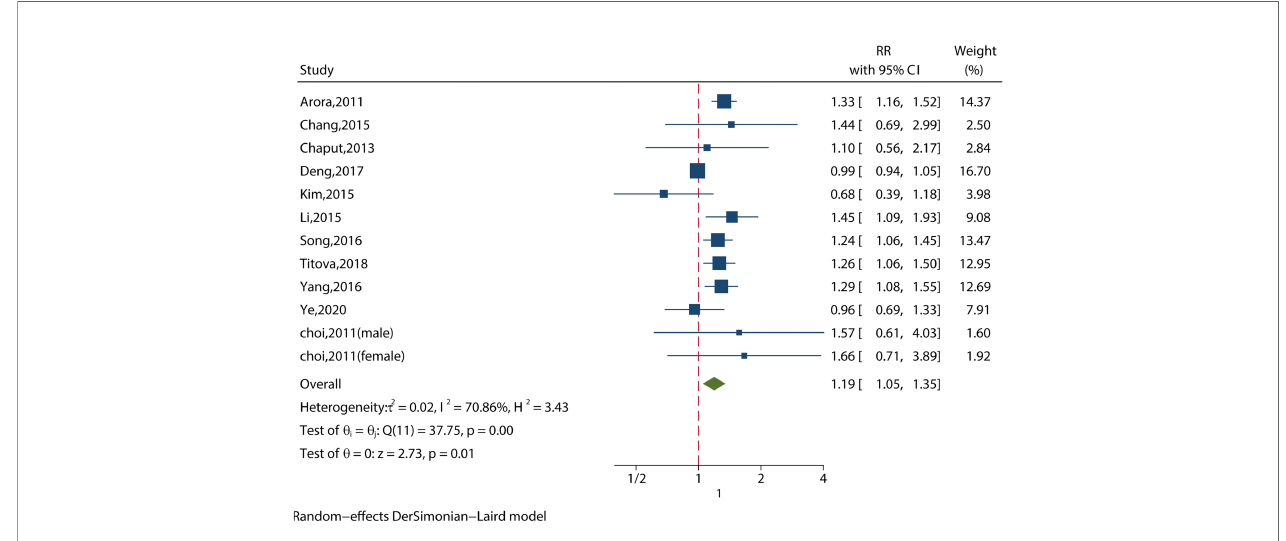
FIGURE 3 | Meta-analysis of the association between long sleep and risk of metabolic syndrome in the most ‐ adjusted model.